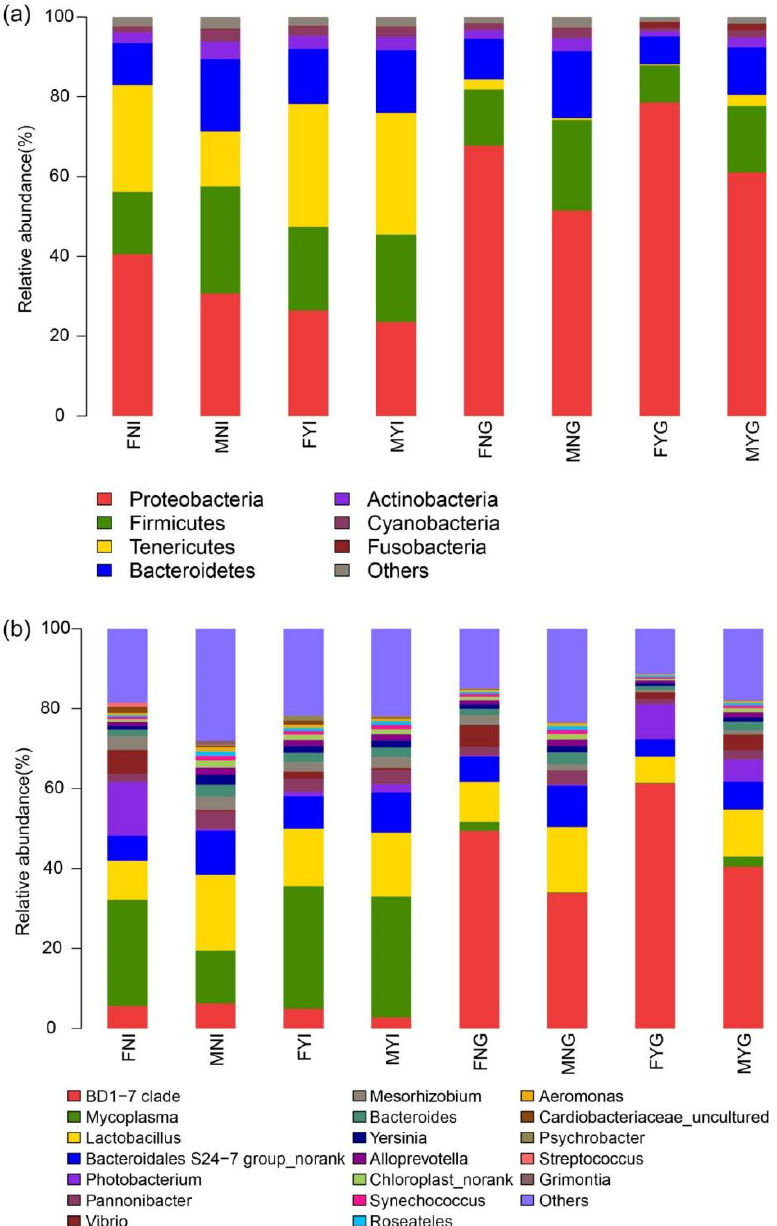
Figure 5. Dominant bacterial community composition in intestinal and gill tissues of dwarf-form squid. ( a ) Phylum level, ( b ) genus level.